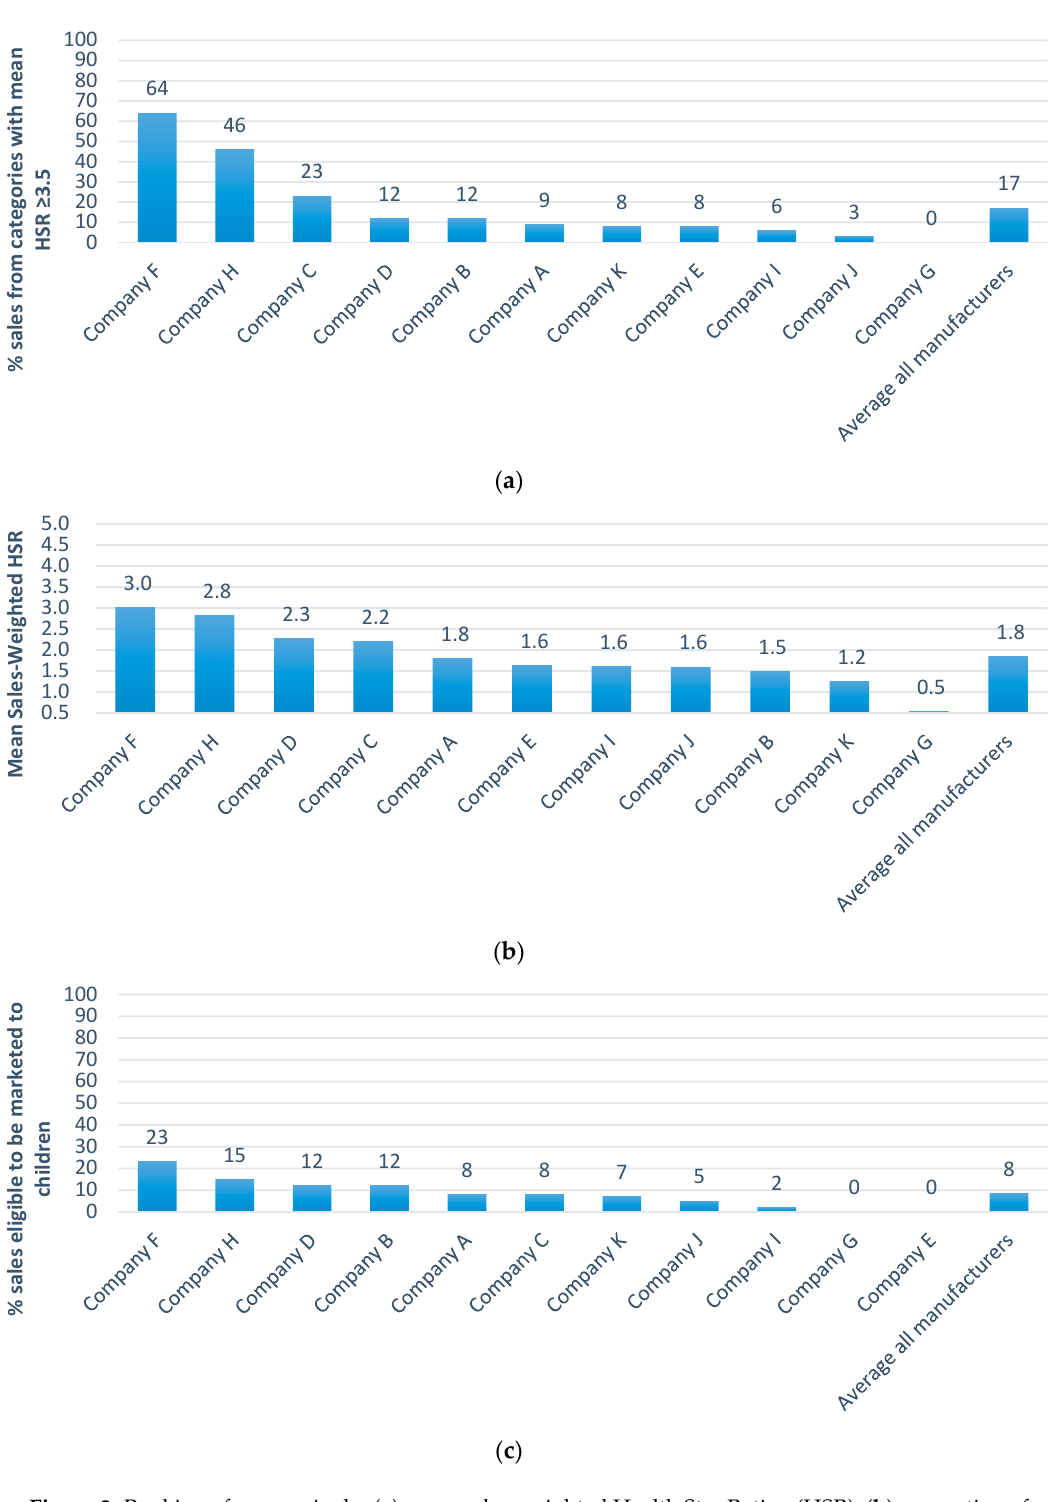
Figure 2. Ranking of companies by ( a ) mean sales-weighted Health Star Rating (HSR); ( b ) proportion of healthy product sales (HSR ≥ 3.5) and ( c ) proportion of product sales eligible for marketing to children.